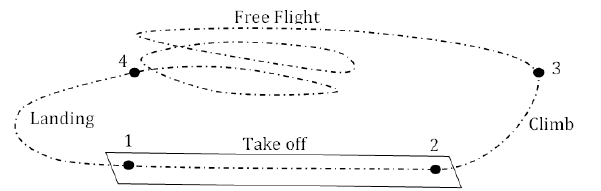
Figure 1. Flight profile of the ACC 2022.